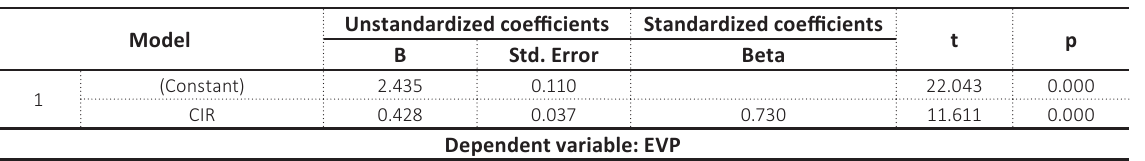
Table 7. Influence of CIR on